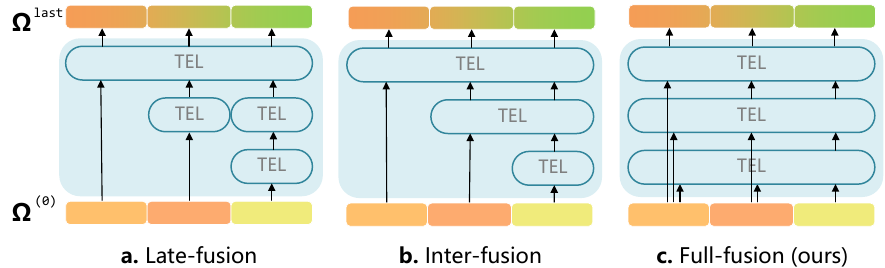
Figure 3. Three modal fusion strategies. TEL is short for Transformer Encoder Layer. The inputs of the TEL are concatenated at temporal dimension. The features of different modalities correspond to different colors. We assign one layer for the first modality, two for the second and three for the third as for example in this